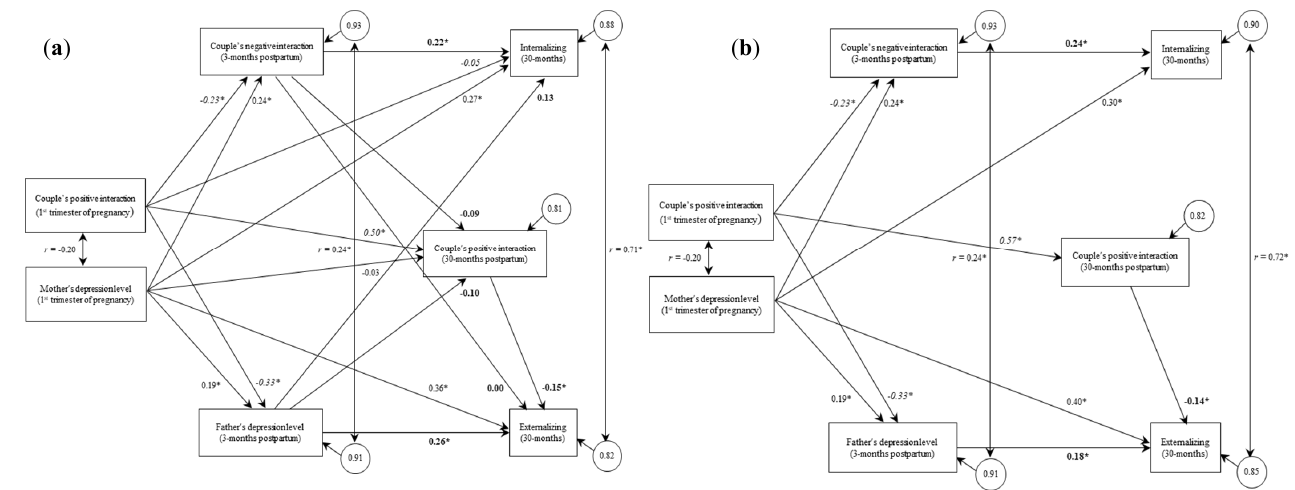
Figure 1. Initial ( a ) and final model ( b ) with standardized values. * p < 0.05.